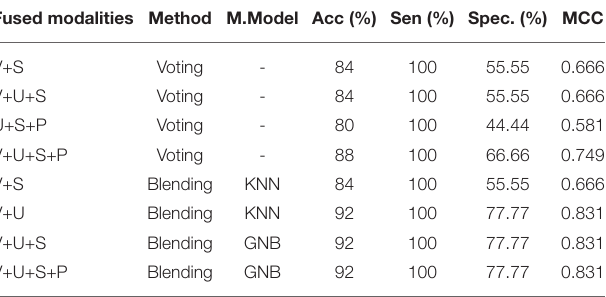
TABLE 11 | Performance offered by the proposed multimodal approach using AC channel.